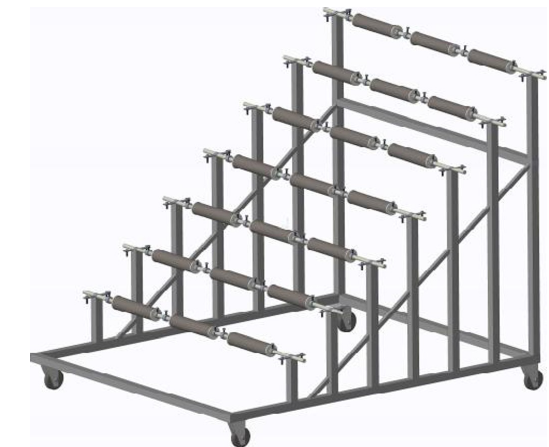
FIG.3 THREE-DIMENSIONAL VIEW OF WARP